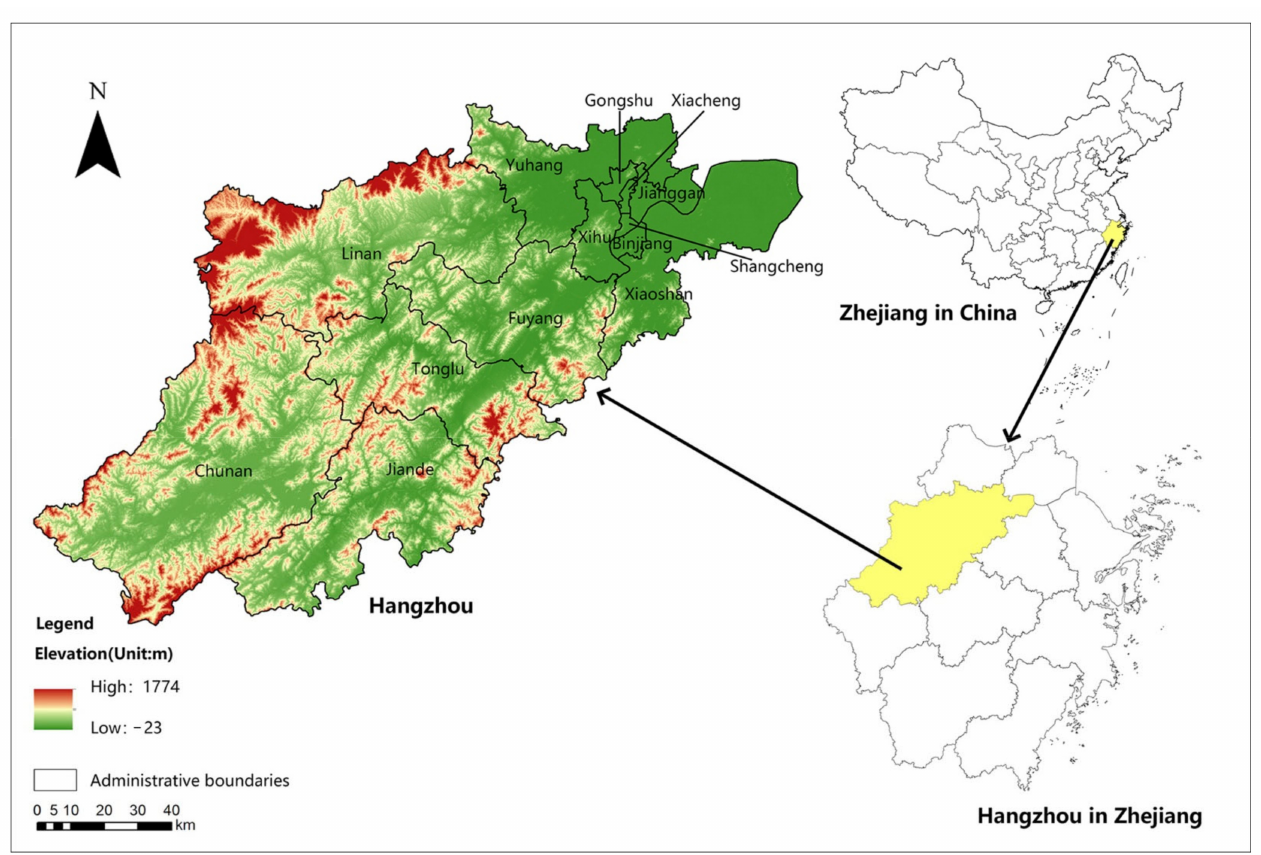
Figure 1. Location of